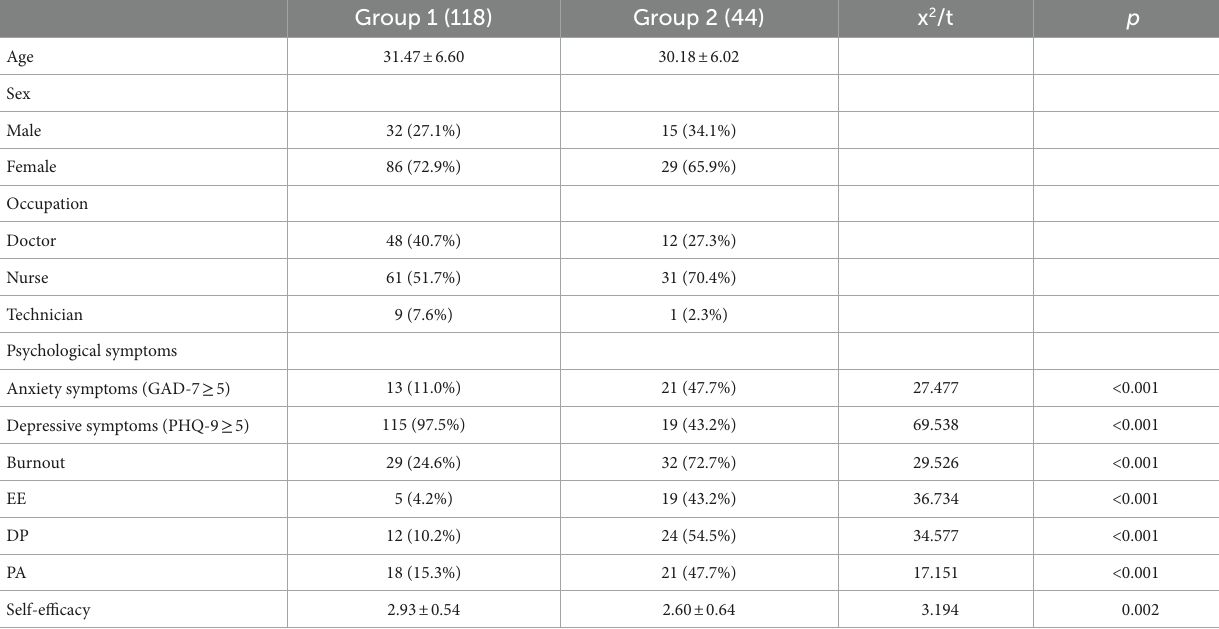
TABLE 1 Demographic information, psychological symptoms, burnout, and self-efficacy scores of